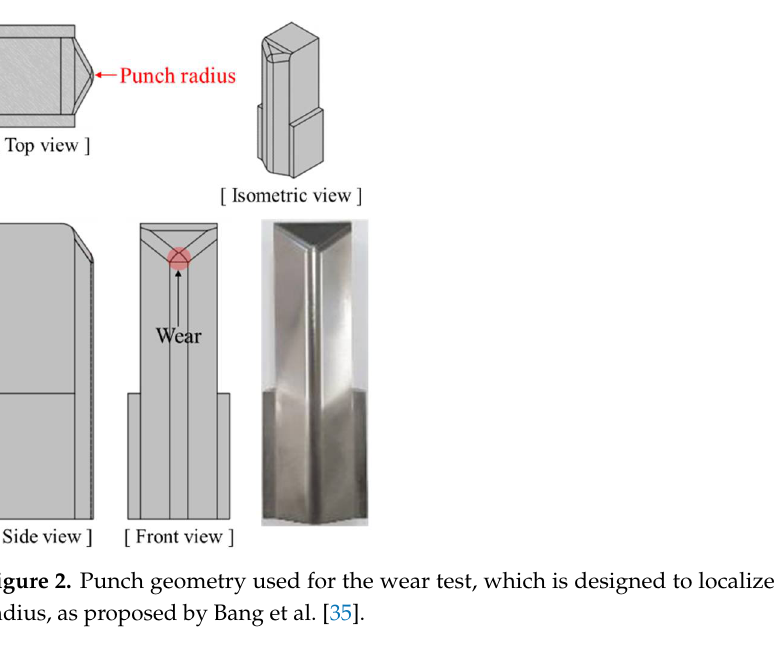
Figure 3. Layout of metalworking operations for the progressive die tool [35]. Table 4. Summary of stamping punch conditions for the wear test.